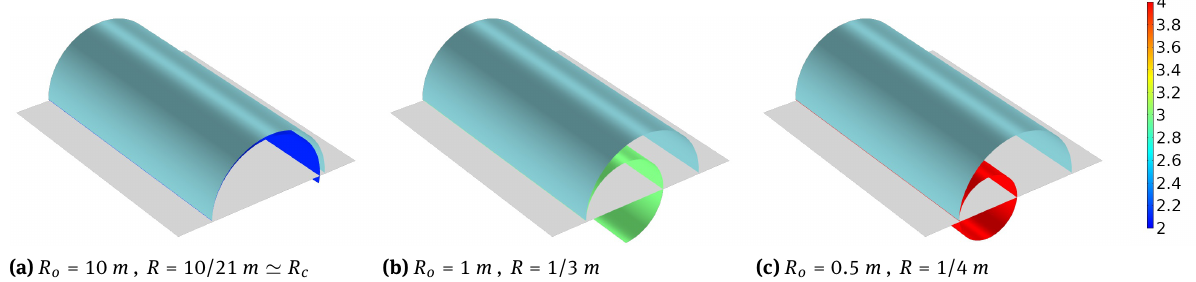
Figure 4: Bending of a cylindrical shell obtained by a change of the target metric B o . Each of the three figures shows the computational domain (gray), the reference surface (cyan), and the actual shape (color map of curvature). Each deformed configuration is stress-free.